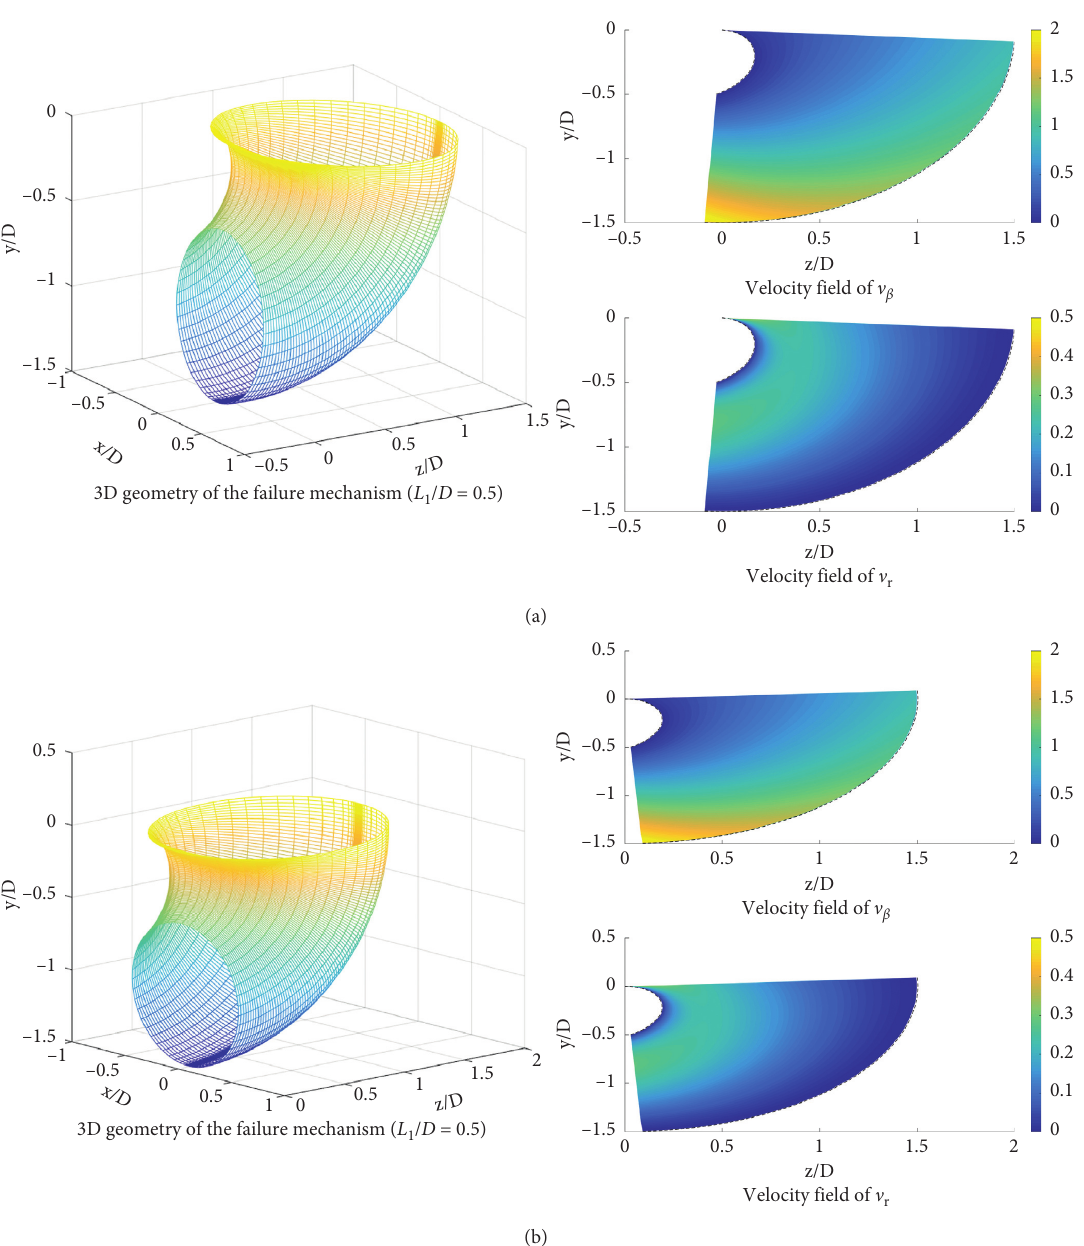
� 10, and η � 6%): (a) tunneling in u